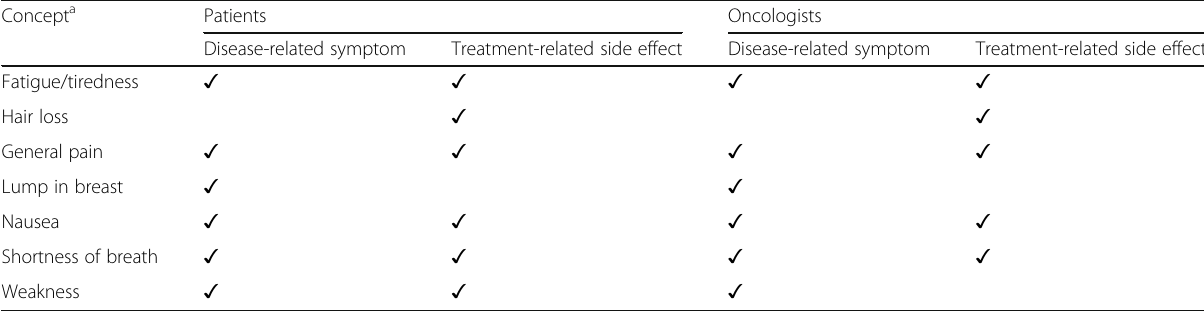
Table 7 Attribution of concepts reported by the patients compared to oncologist reports Concept